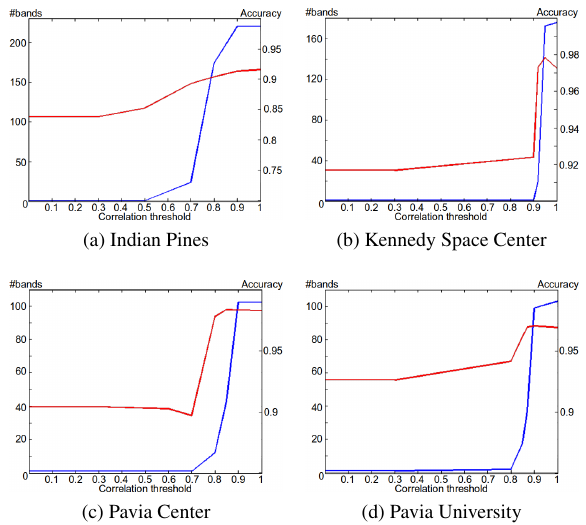
Figure 7: Number of bands (blue) and balanced accuracy (red) for different correlation